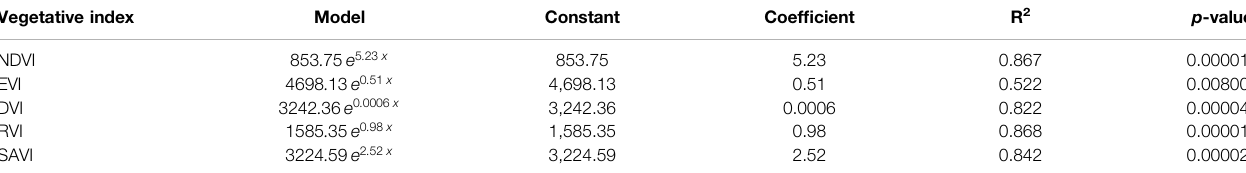
TABLE 8 | The regression model applied to estimate carbon stock in avenue and street plantings